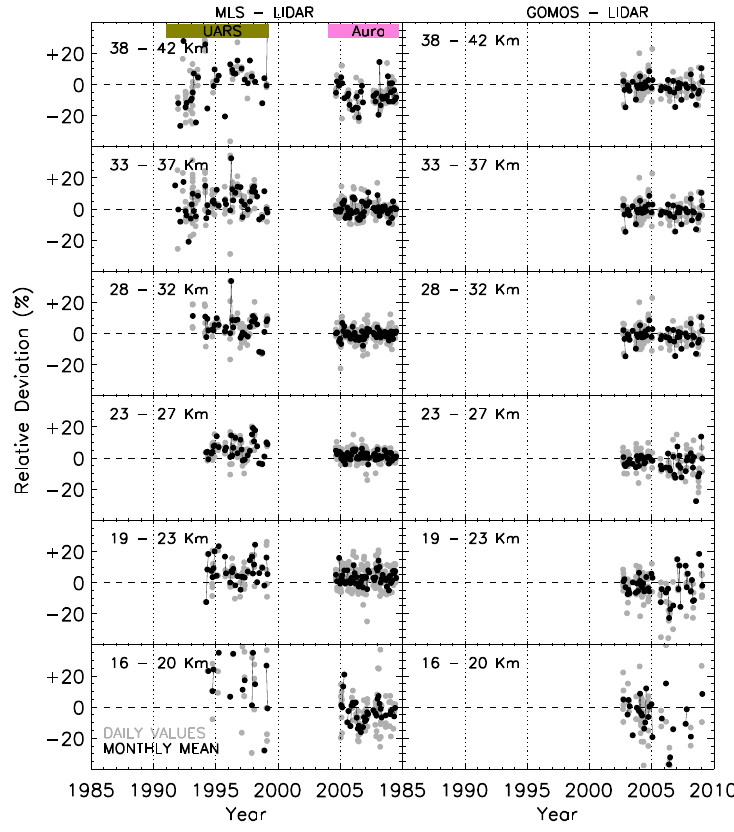
Fig. 6. Same as Fig. 3, but for MLS on UARS and Aura satellites (left panel) and GOMOS (right panel). The period of observations of UARS MLS and Aura MLS are shown with respective colour shades, as for Fig. 1.